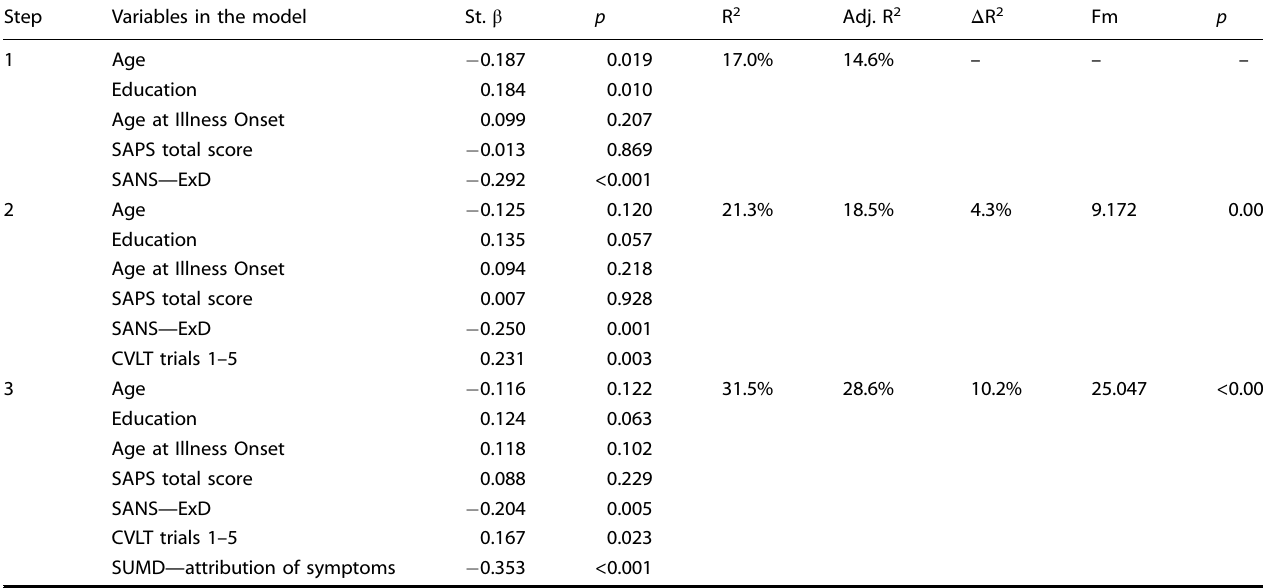
St. standardized, Adj. adjusted, Fm F-value associated with the modi fi cation, SAPS Scale for the Assessment of Positive Symptoms, SANS Scale for the Assessment of Negative Symptoms, ExD expressive de fi cit dimension of negative symptoms, CVLT California Verbal Learning Test, SUMD Scale of Unawareness of Mental